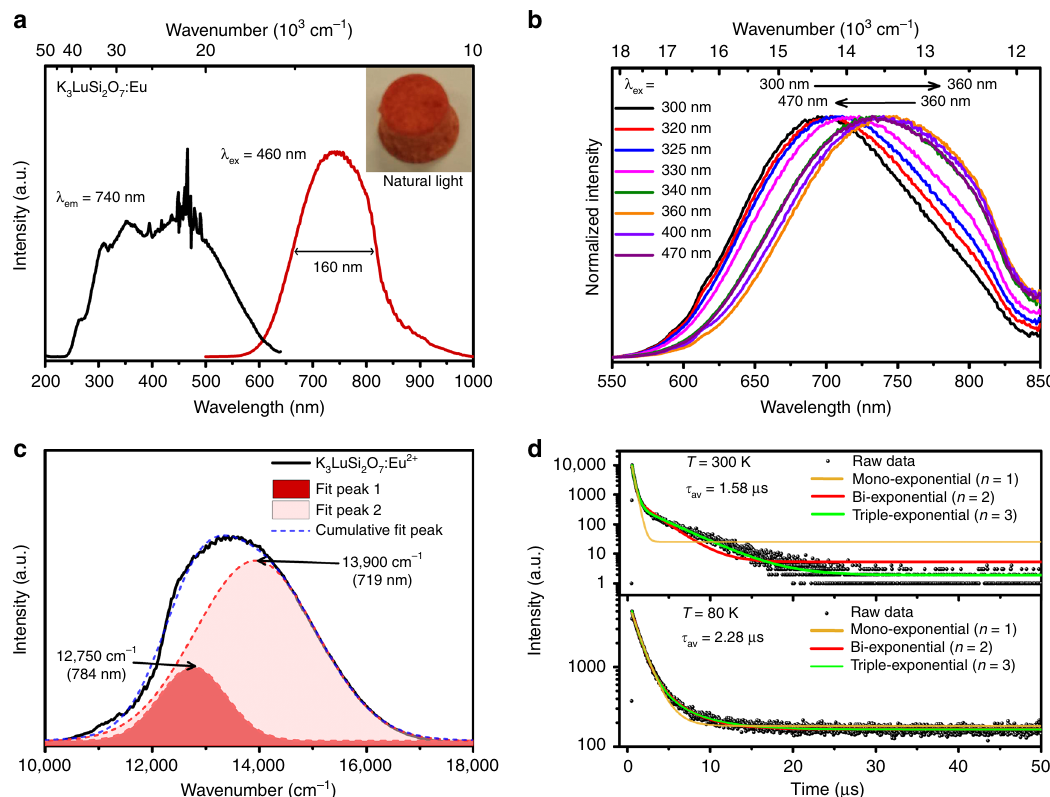
Fig. 2 Photoluminescence properties of K 3 LuSi 2 O 7 :Eu 2 + phosphors. a PL and PLE spectra of K 3 LuSi 2 O 7 :0.01Eu 2 + measured/monitored at 460 and 740 nm, and the inset shows the photograph of K 3 LuSi 2 O 7 :0.01Eu 2 + with deep red body color under natural light. b Room temperature PL spectra of K 3 LuSi 2 O 7 :0.01Eu 2 + under different excitation wavelength from 300 to 470 nm. c The emission spectrum of the K 3 LuSi 2 O 7 :0.01Eu 2 + and Gaussian fi tting curves. d Decay curves and fi tting results of K 3 LuSi 2 O 7 :0.01Eu measured at 80 K and 300 K under 450 nm pulse laser diode